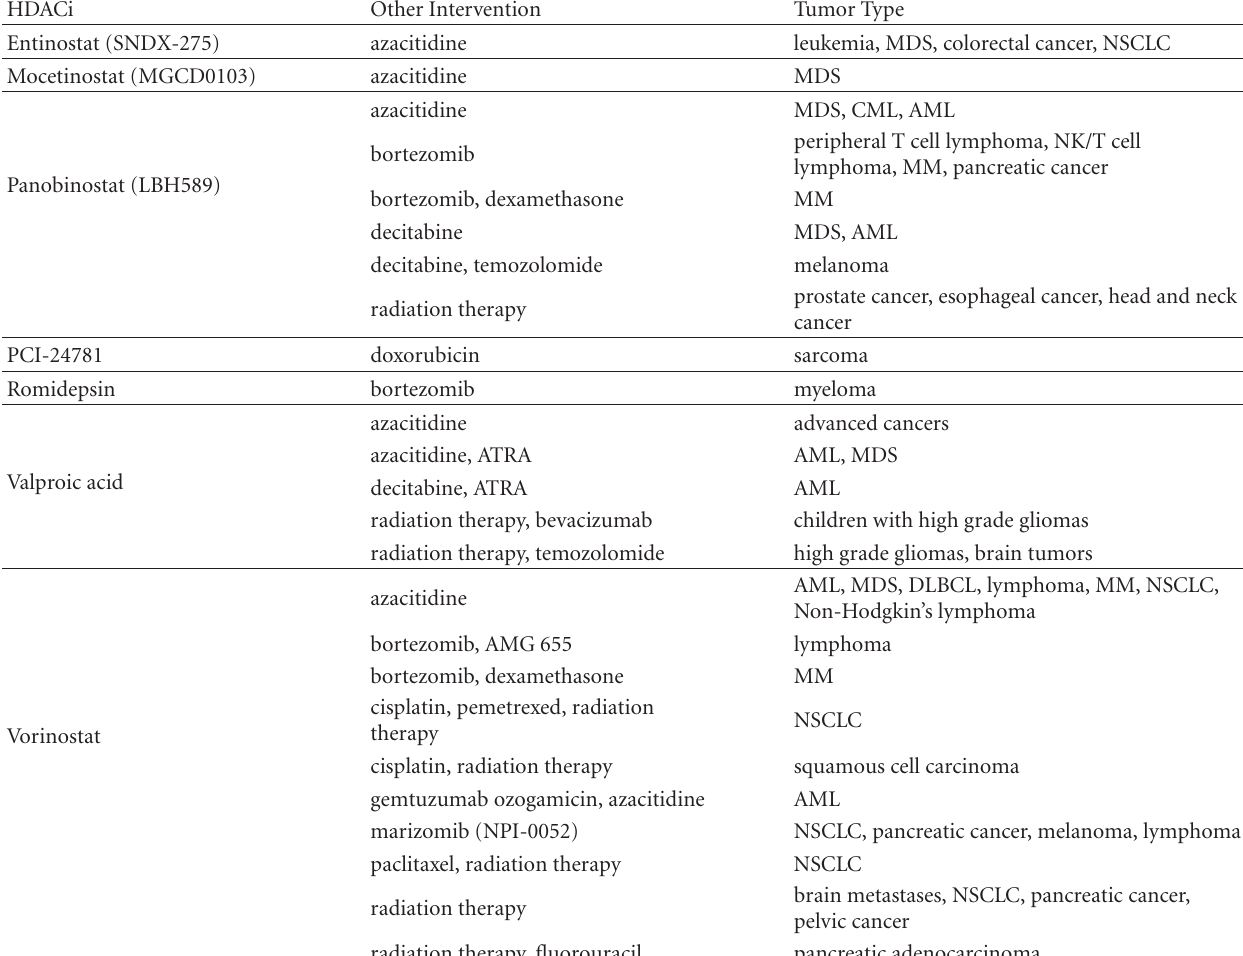
Table 1: HDACi combination regimens currently in clinical trials. Partial list of clinical trials evaluating the combination of HDACi with other anticancer agents discussed in this paper (source: http://www.clinicaltrials.gov/,